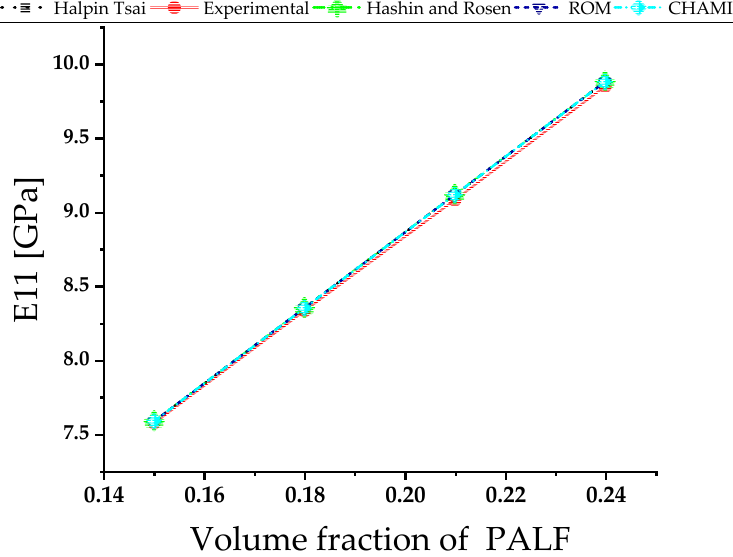
Figure 8. Transverse Young’s modulus 𝐸 (cid:2870)(cid:2870) of PALF /epoxy in terms of different volume fractions of fiber.